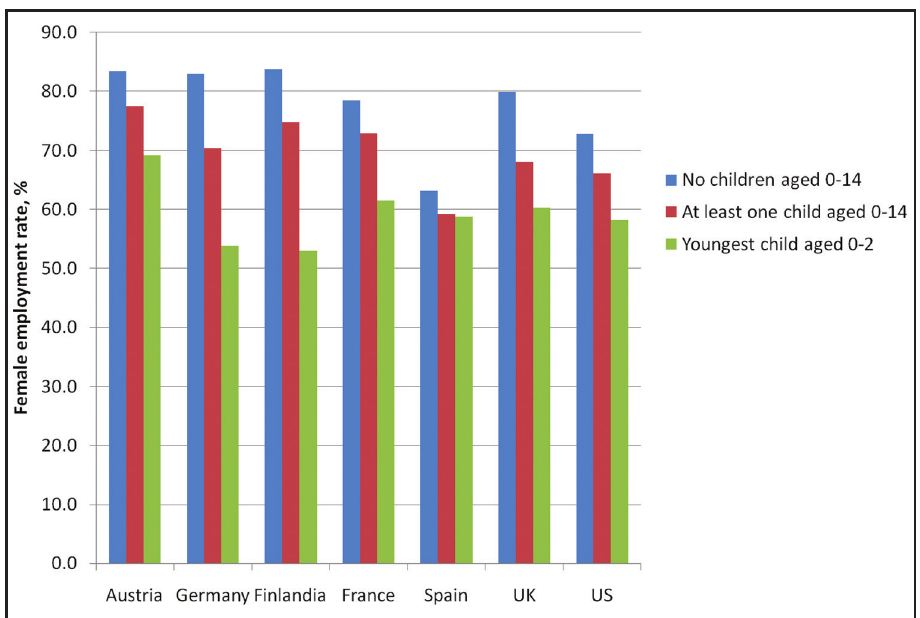
Figure 1 Employment rates of females aged 25–54 years by age of the youngest child,